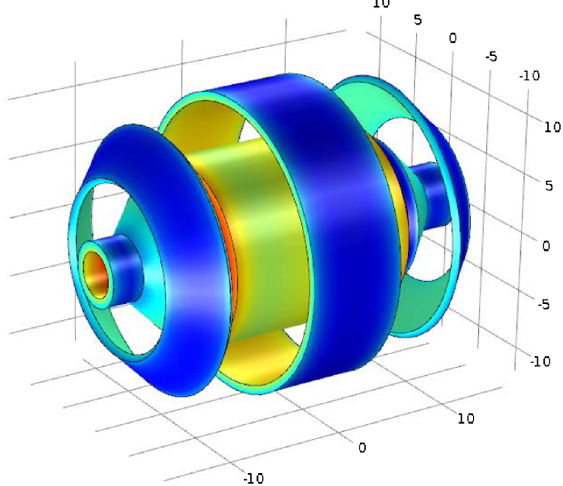
FIG. 9. Three-dimensional representation of the spherical detector assembly. The color indicates the field on the surface of the cold mass (see the legend in Fig. 10).